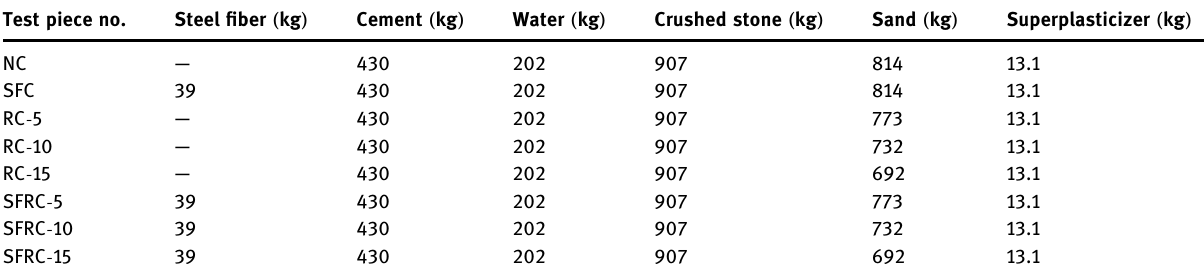
Table 1: Concrete mix proportion of various test pieces Test piece no.